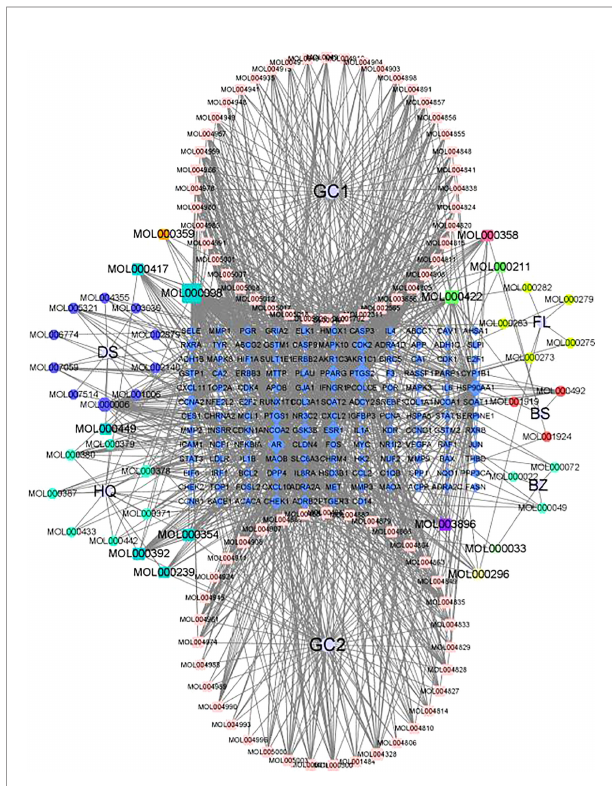
FIGURE 11 | TCM group regulatory